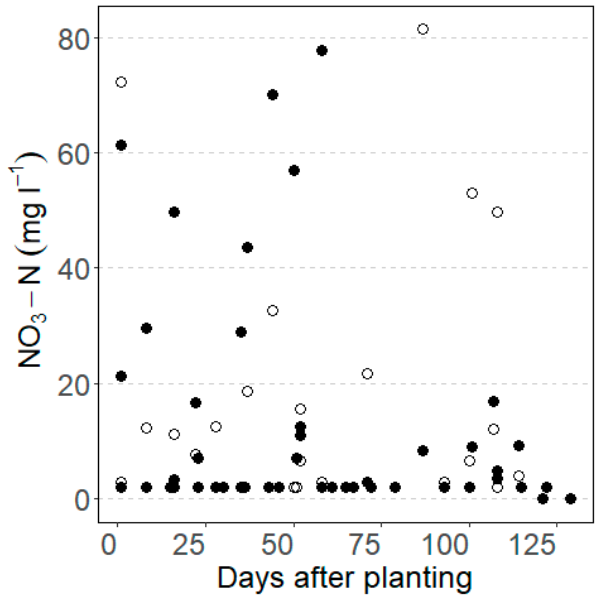
Figure 5. NO 3 -N concentrations of a soil solution collected at 0.30 ( ○ ) and 0.60 m ( ● ) depth using suction samplers in six farmers ’ fields.